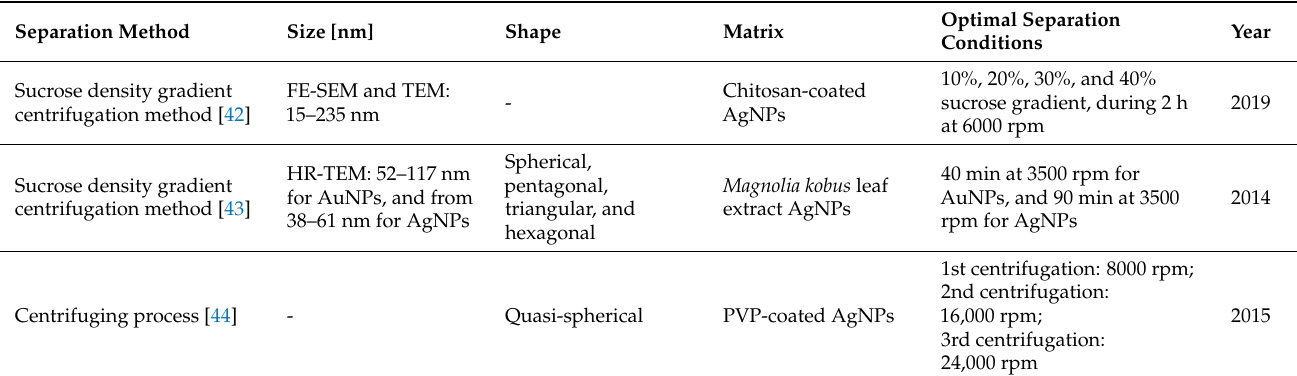
Table 4. Overview of AgNPs separation based on